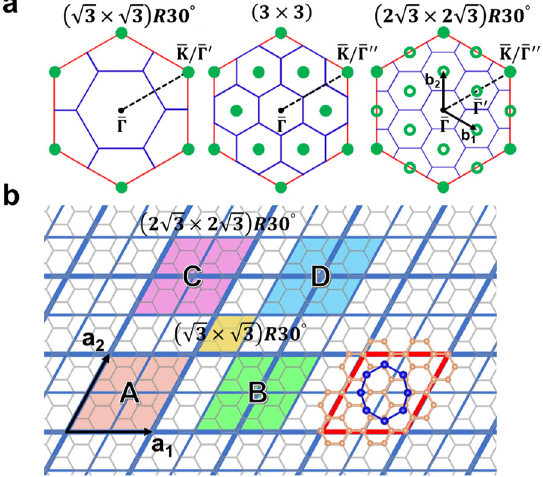
ffiffiffi p ffiffiffi p (cid:3) (cid:4) ´ 2 3 3 R 30 (cid:2)